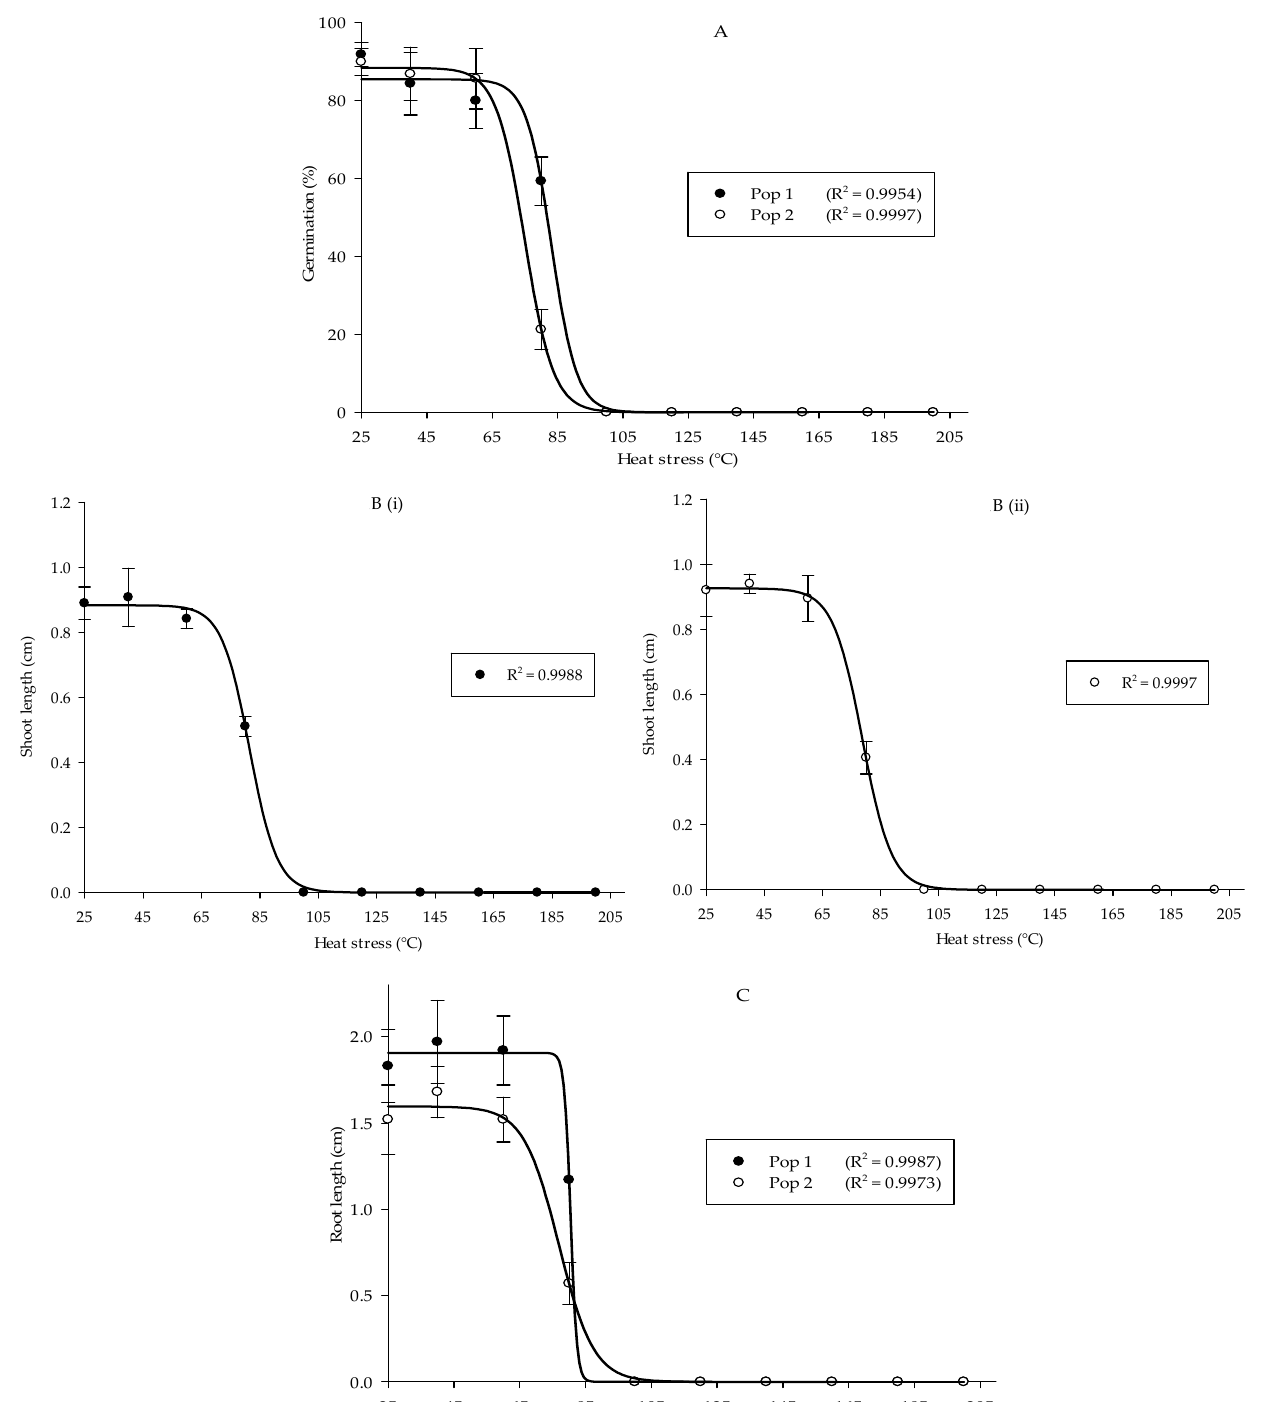
Figure 1. Percentage of seed germination of Pop 1 and Pop 2 ( A ), shoot length of Pop 1 ( Bi ) and Pop 2 ( Bii ), and root length of Pop 1 and Pop 2 ( C ) of Parthenium weed under different heat stress treatments.